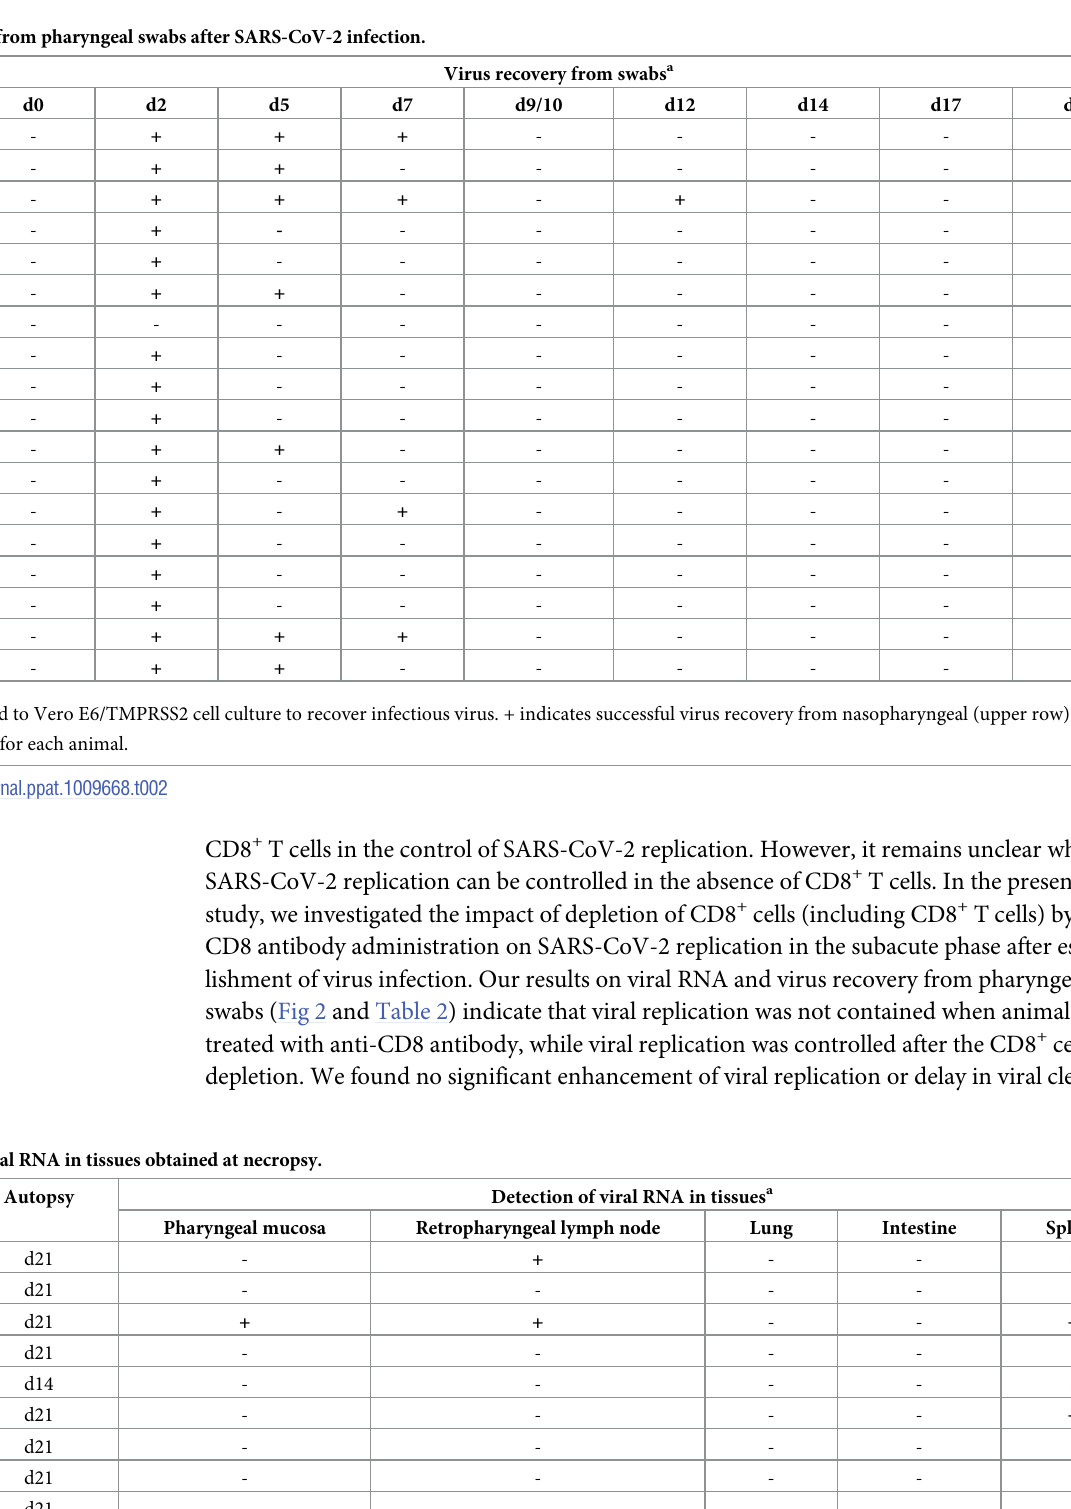
Table 2. Virus recovery from pharyngeal swabs after SARS-CoV-2 infection. Macaques